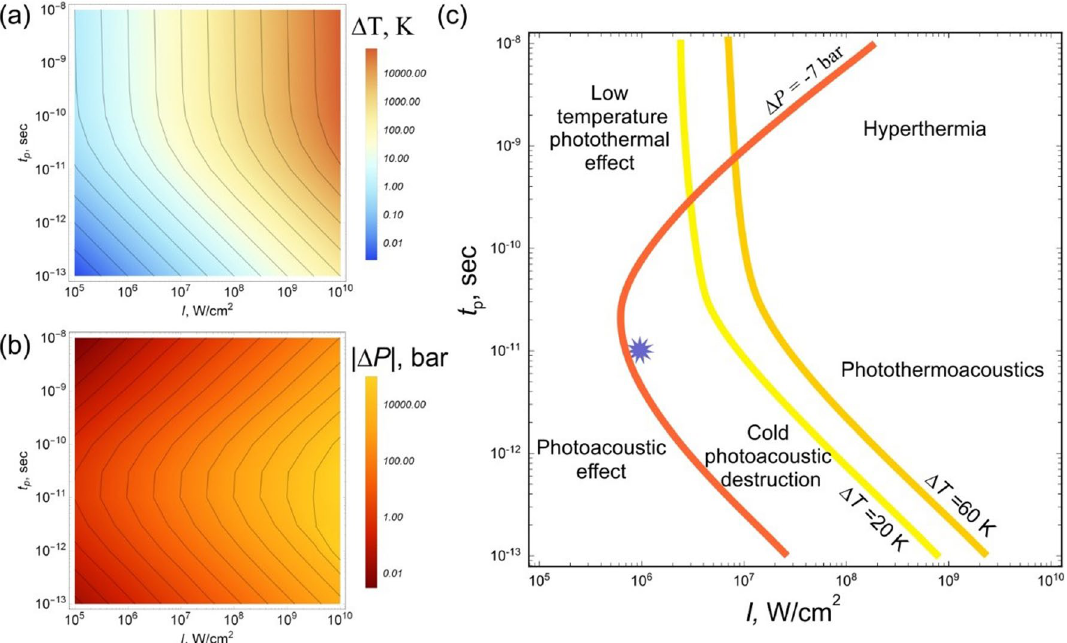
Figure 1. Numerical simulation of the interaction of laser radiation with the SWCNT agglomerate embedded into the living cell. Contour maps of the ( a ) temperature increase and ( b ) negative pressure in the SWCNT agglomerate of R 0 = 1 µm (see Supplementary Information for details) aggregated inside the glioma cell on the pulse duration/intensity plane. ( c ) Isotherms at Δ T = 20 K and Δ T = 60 K, respectively, and isobar at Δ P = − 0.7 MPa. The star corresponds to the experimental